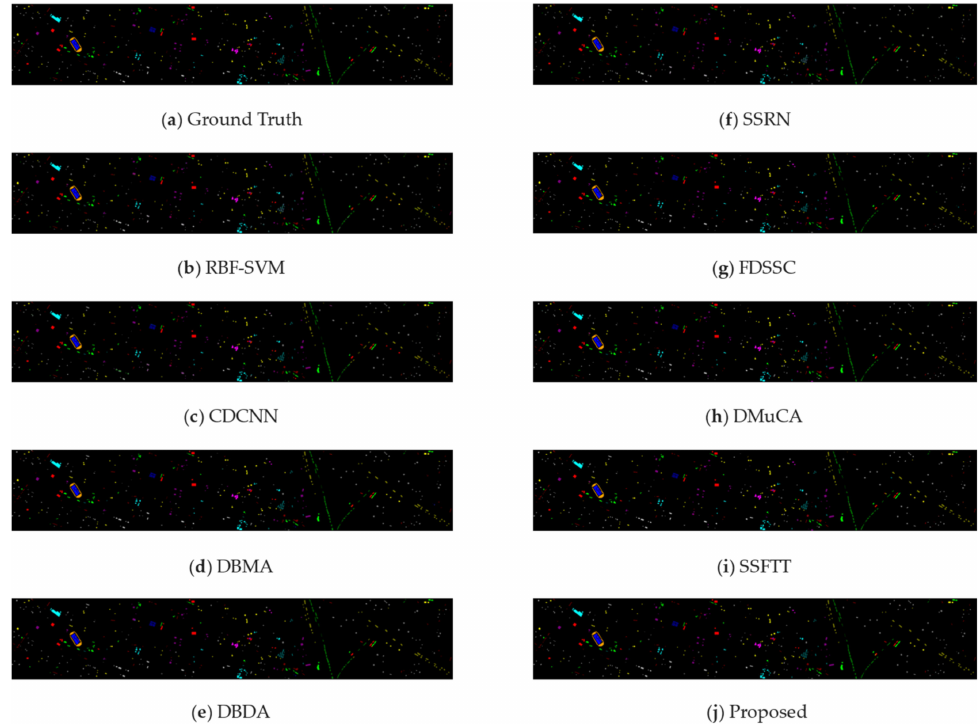
Figure 14. Classification maps of the Houston dataset with 10% training